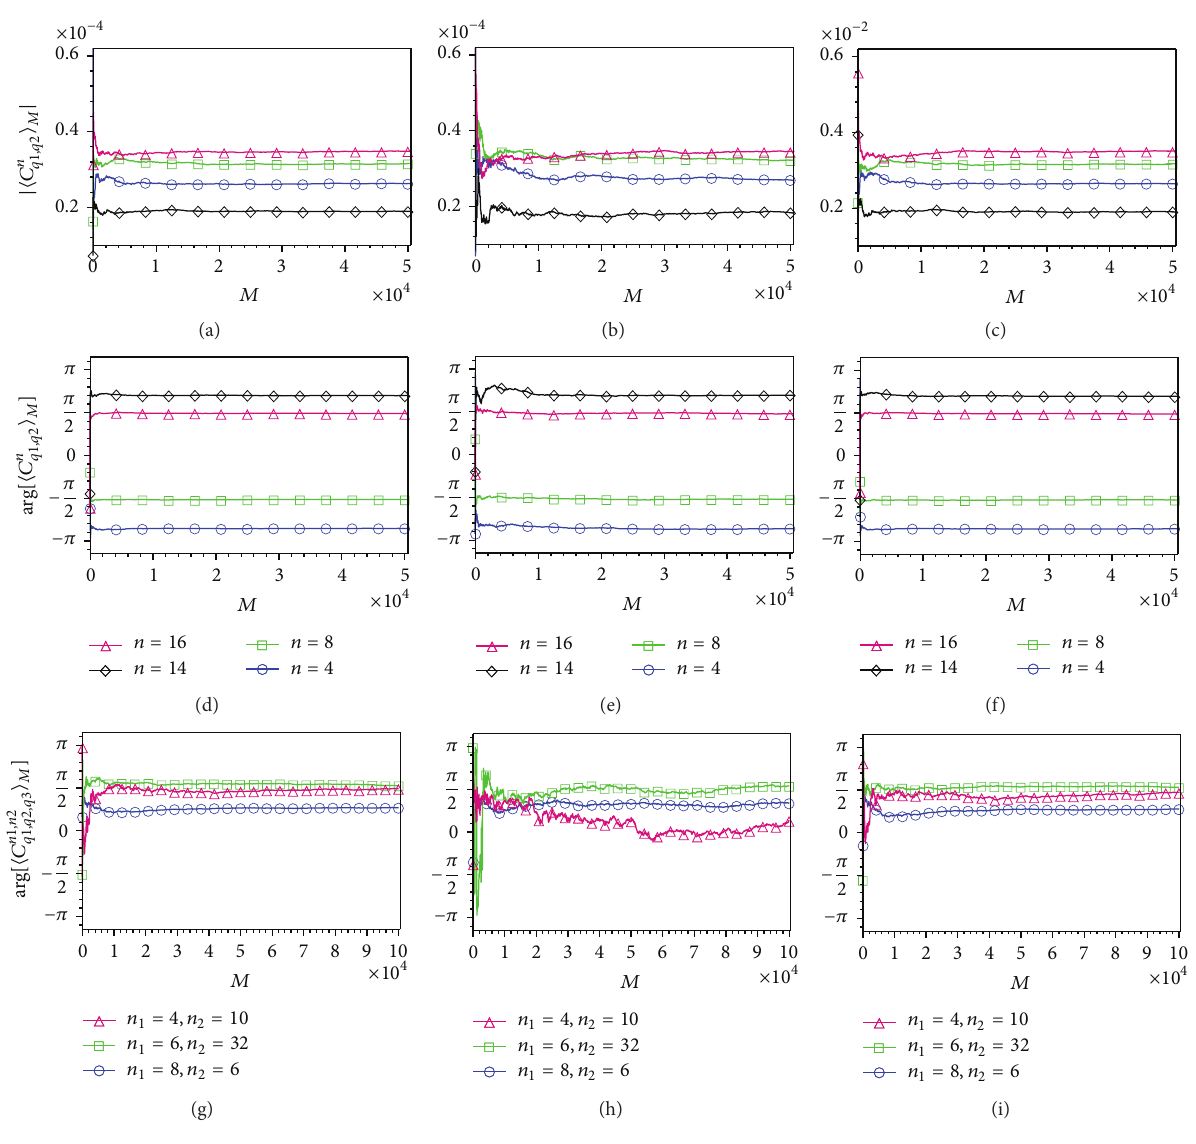
⟩ | and phases arg [⟨𝐶 𝑛 𝑀 1 ,𝑞 2